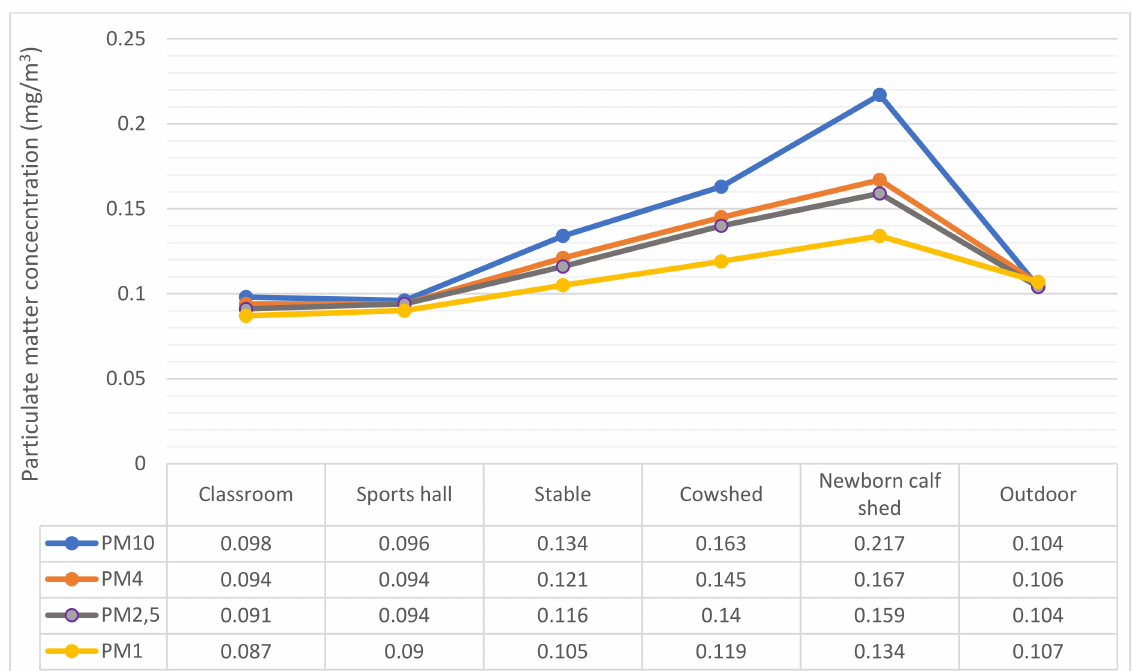
Figure 2. Mean concentrations of different particulate matter fractions in the studied premises (mg/m 3